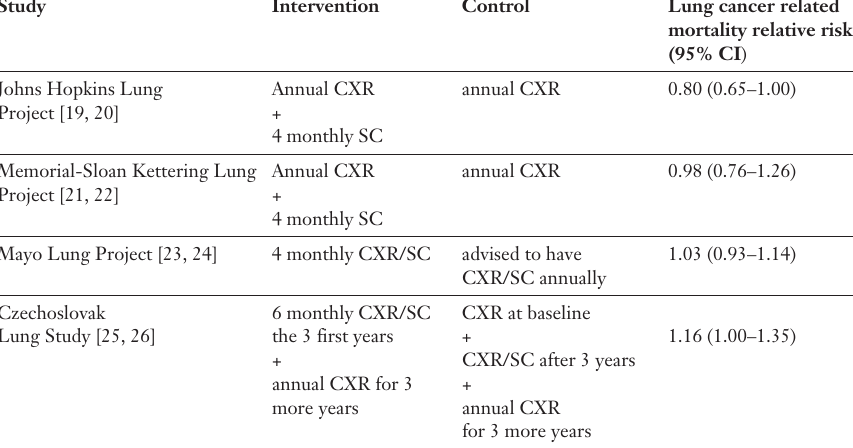
Table 1 RCTs evaluating chest radiography and sputum cytology as a screening